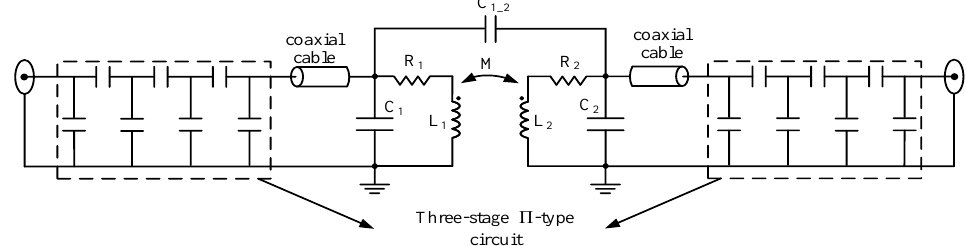
Figure 10. The remote reactance three-stage Π -type matching for the orthogonal dual-coil probe.